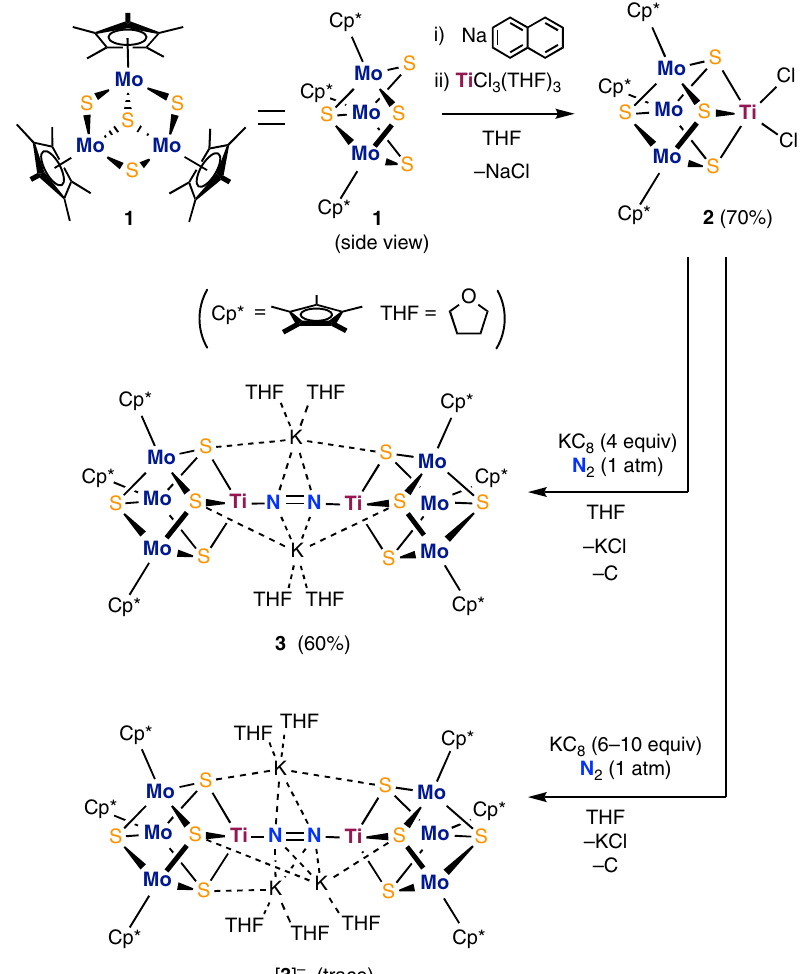
Fig. 2 Reactions in this study. Synthesis of the cubic [Mo 3 S 4 Ti] cluster 2 , the N 2 -binding cluster 3 , and its 1e reduced form [ 3 ] – ; Cp* = η 5 - pentamethylcyclopentadienyl; THF tetrahydrofuran